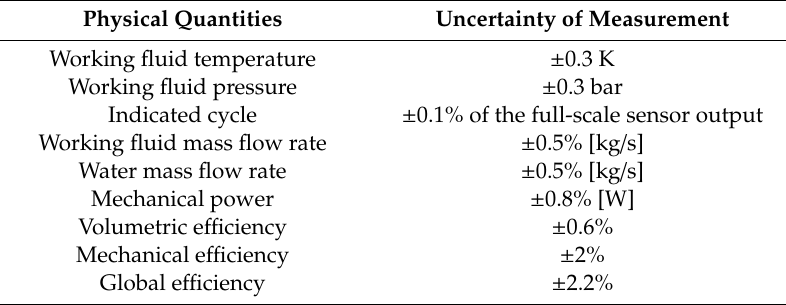
Table 2. Uncertainties of